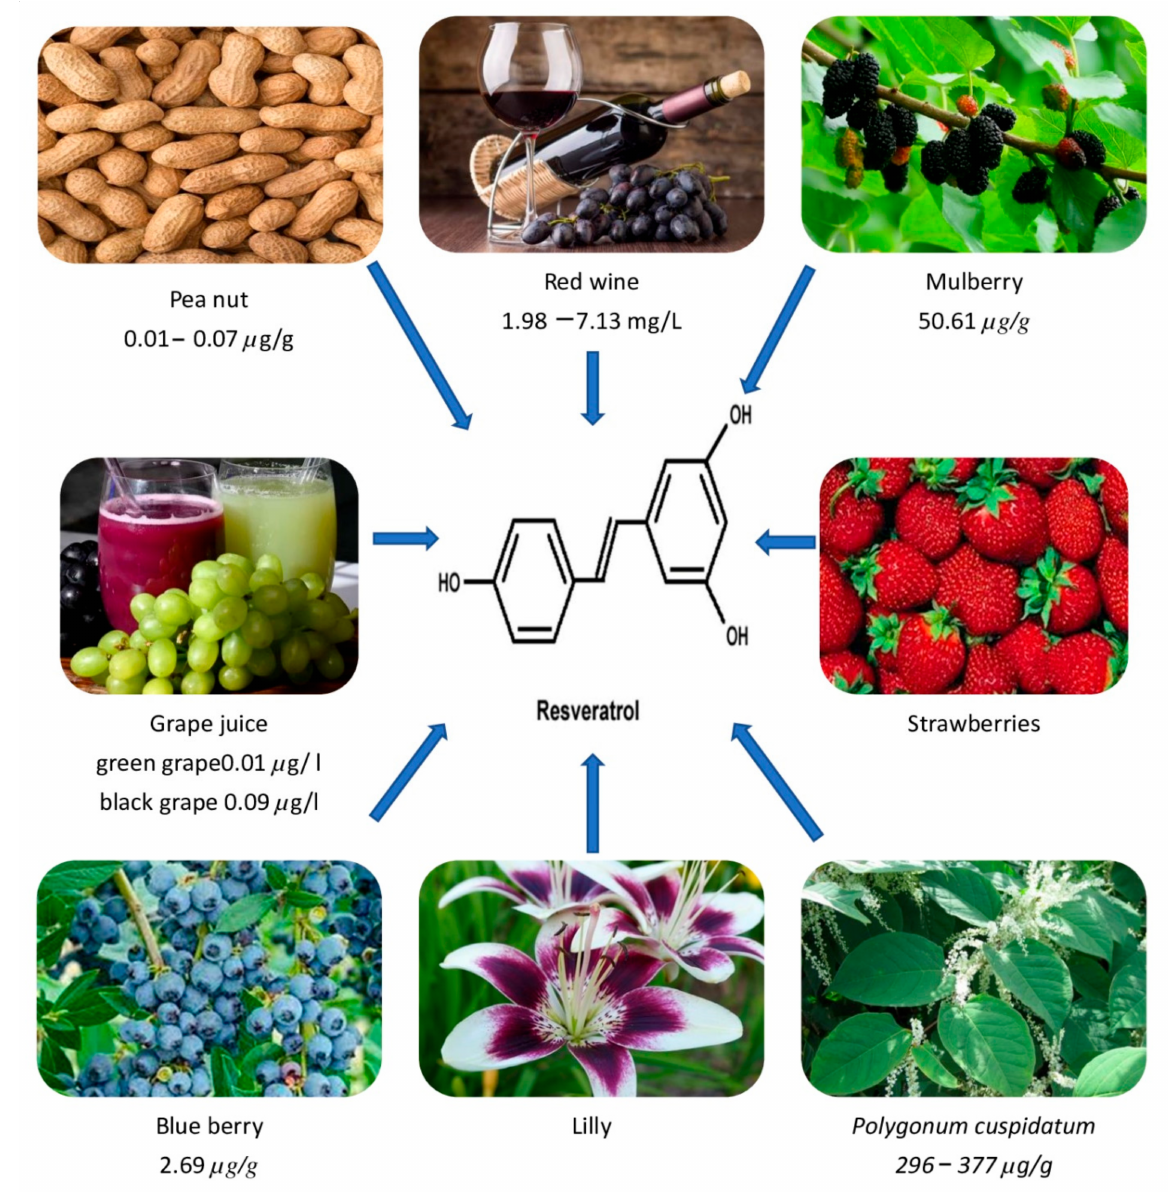
Figure 1. shows the occurrence of RVT in different